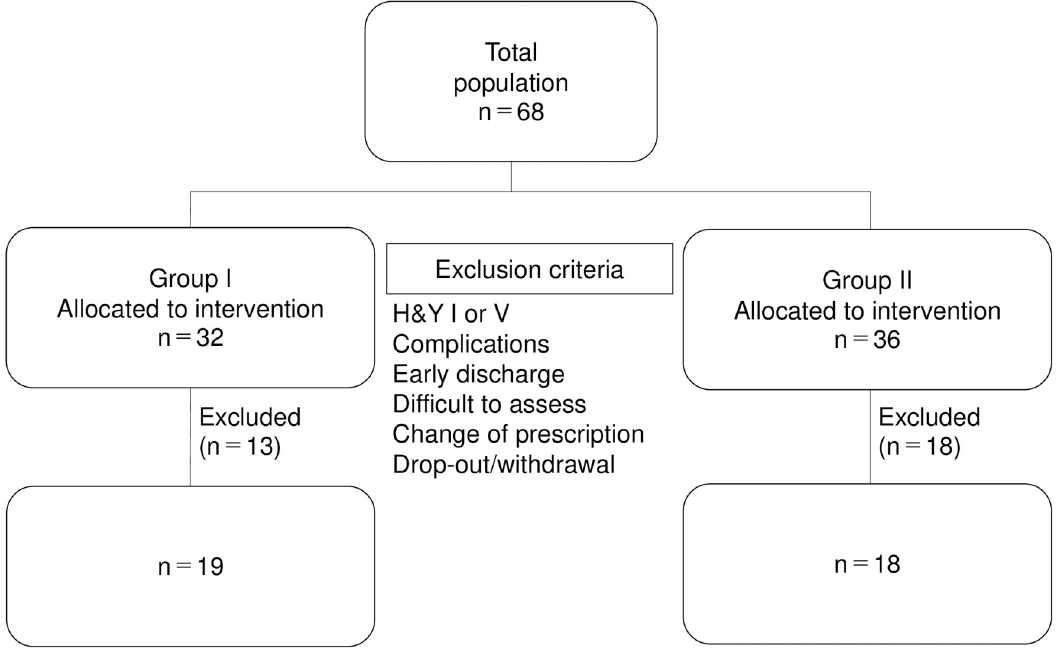
Fig 1. Flow chart showing participant selection with exclusion